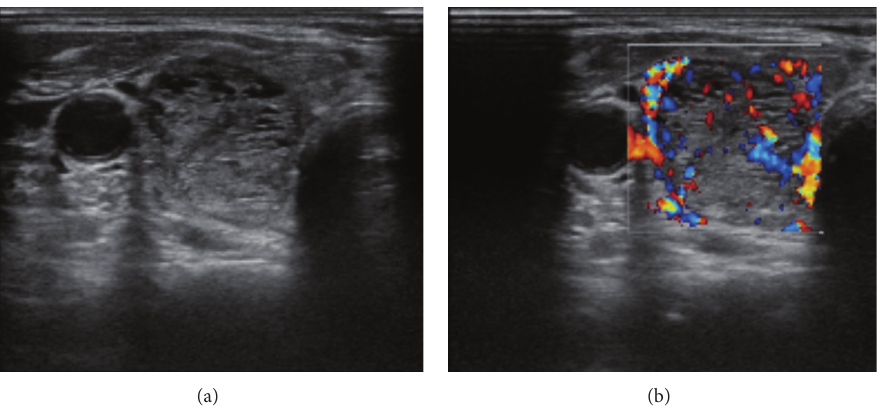
Figure 1: Ultrasonography of the right lobe. A hypoechoic, inhomogeneous mass with a sharp border was detected in the right lobe. The